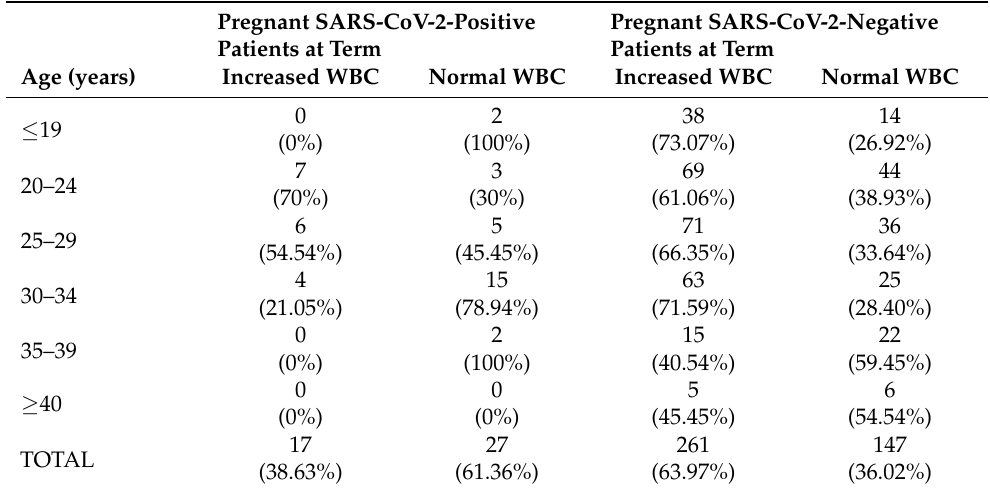
Table 3. Number and percentage of pregnant SARS-CoV-2-positive and negative patients with a WBC over the normal limits at term by age group.